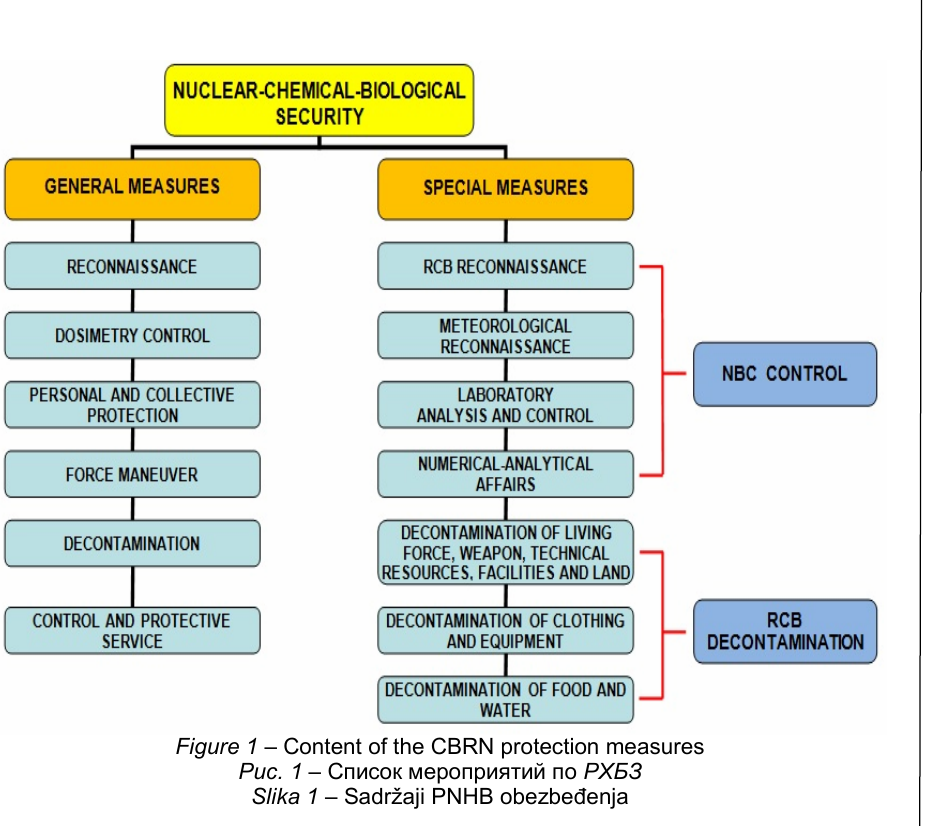
Figure 1 – Content of the CBRN protection measures Рис . 1 – Список мероприятий по